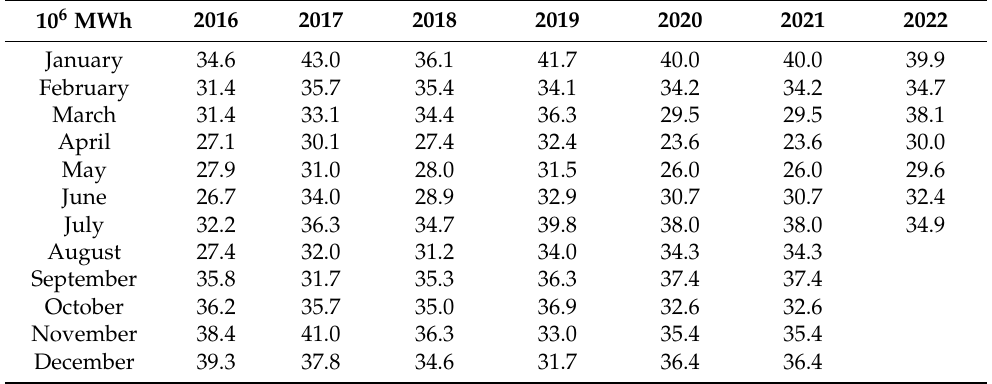
Figure 1. Forecast of natural gas supply to Italian end users for 2024. These data can be found here: https://www.ec.europa.eu/ (accessed on 20 March 2022). Table 1. Final Consumers.